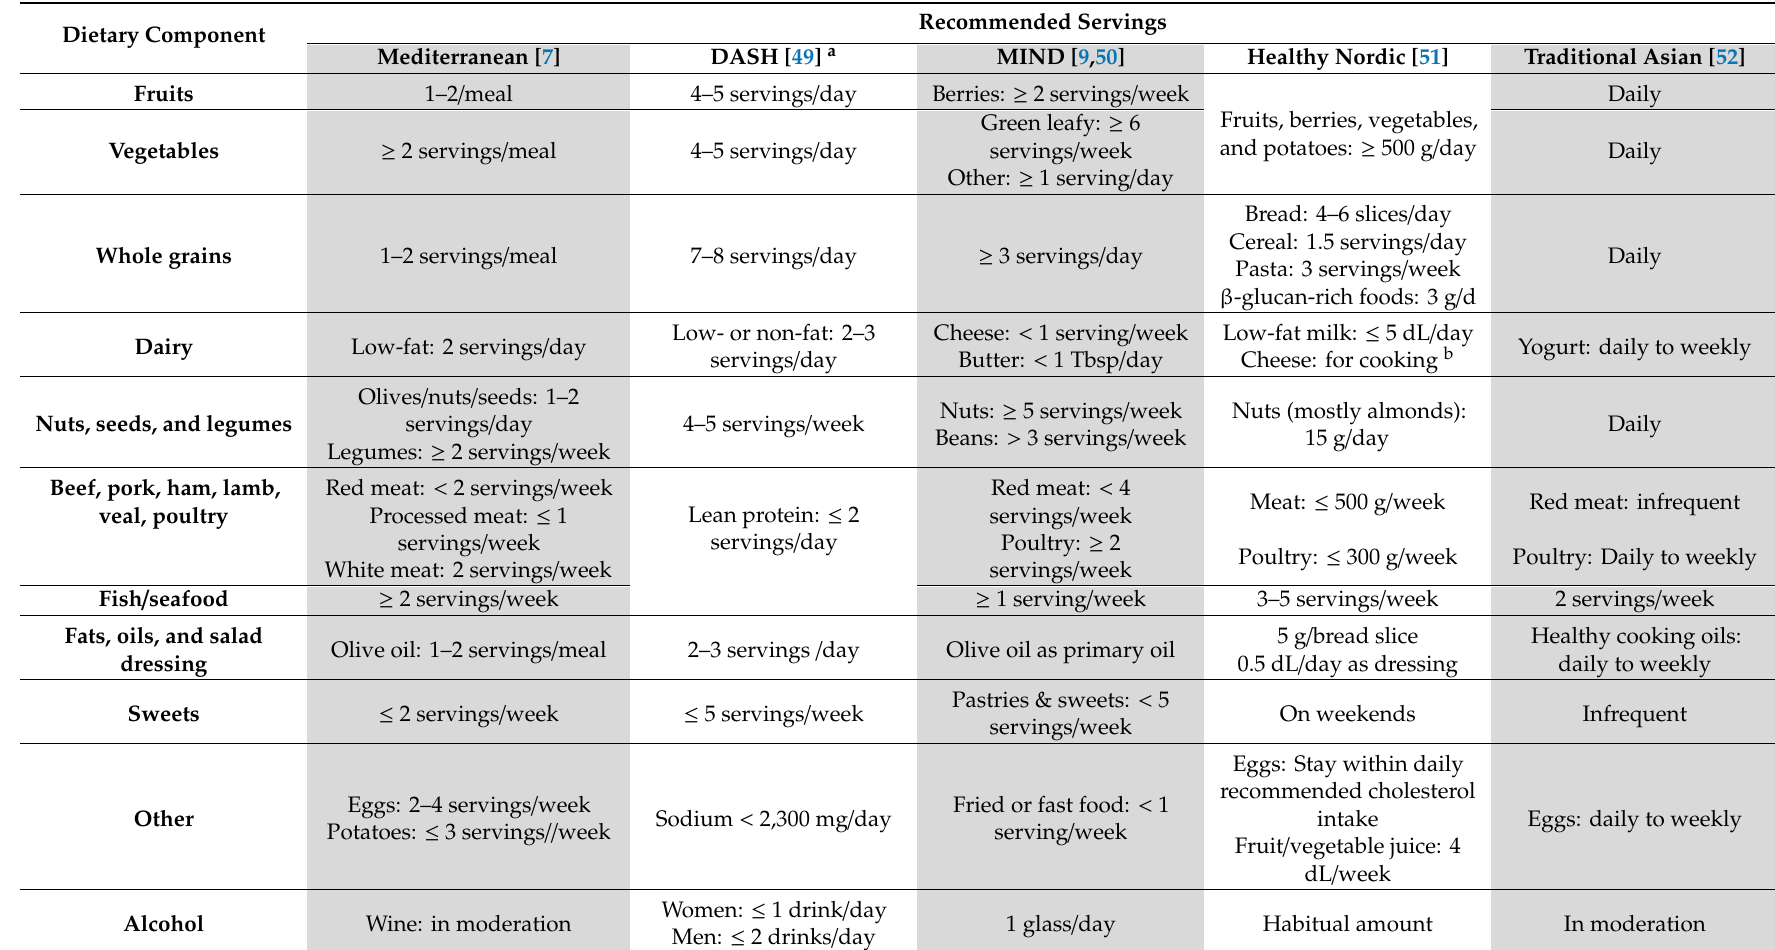
Table 1. Comparison of nutritional / lifestyle components among di ff erent healthy diet